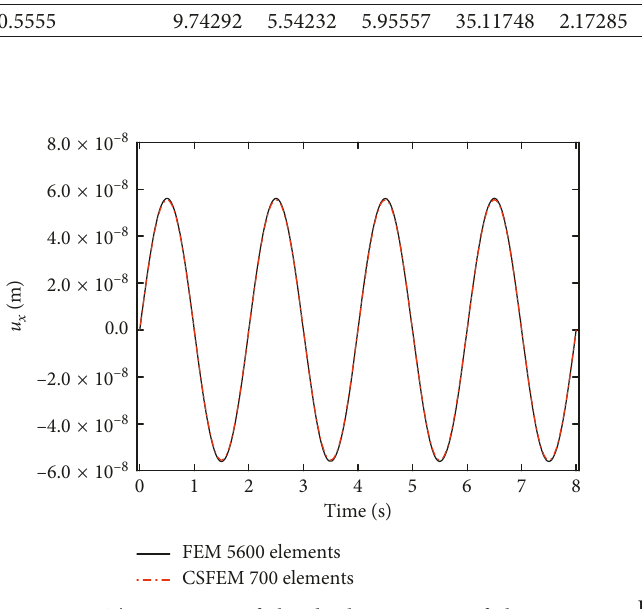
z of the PCMs energy